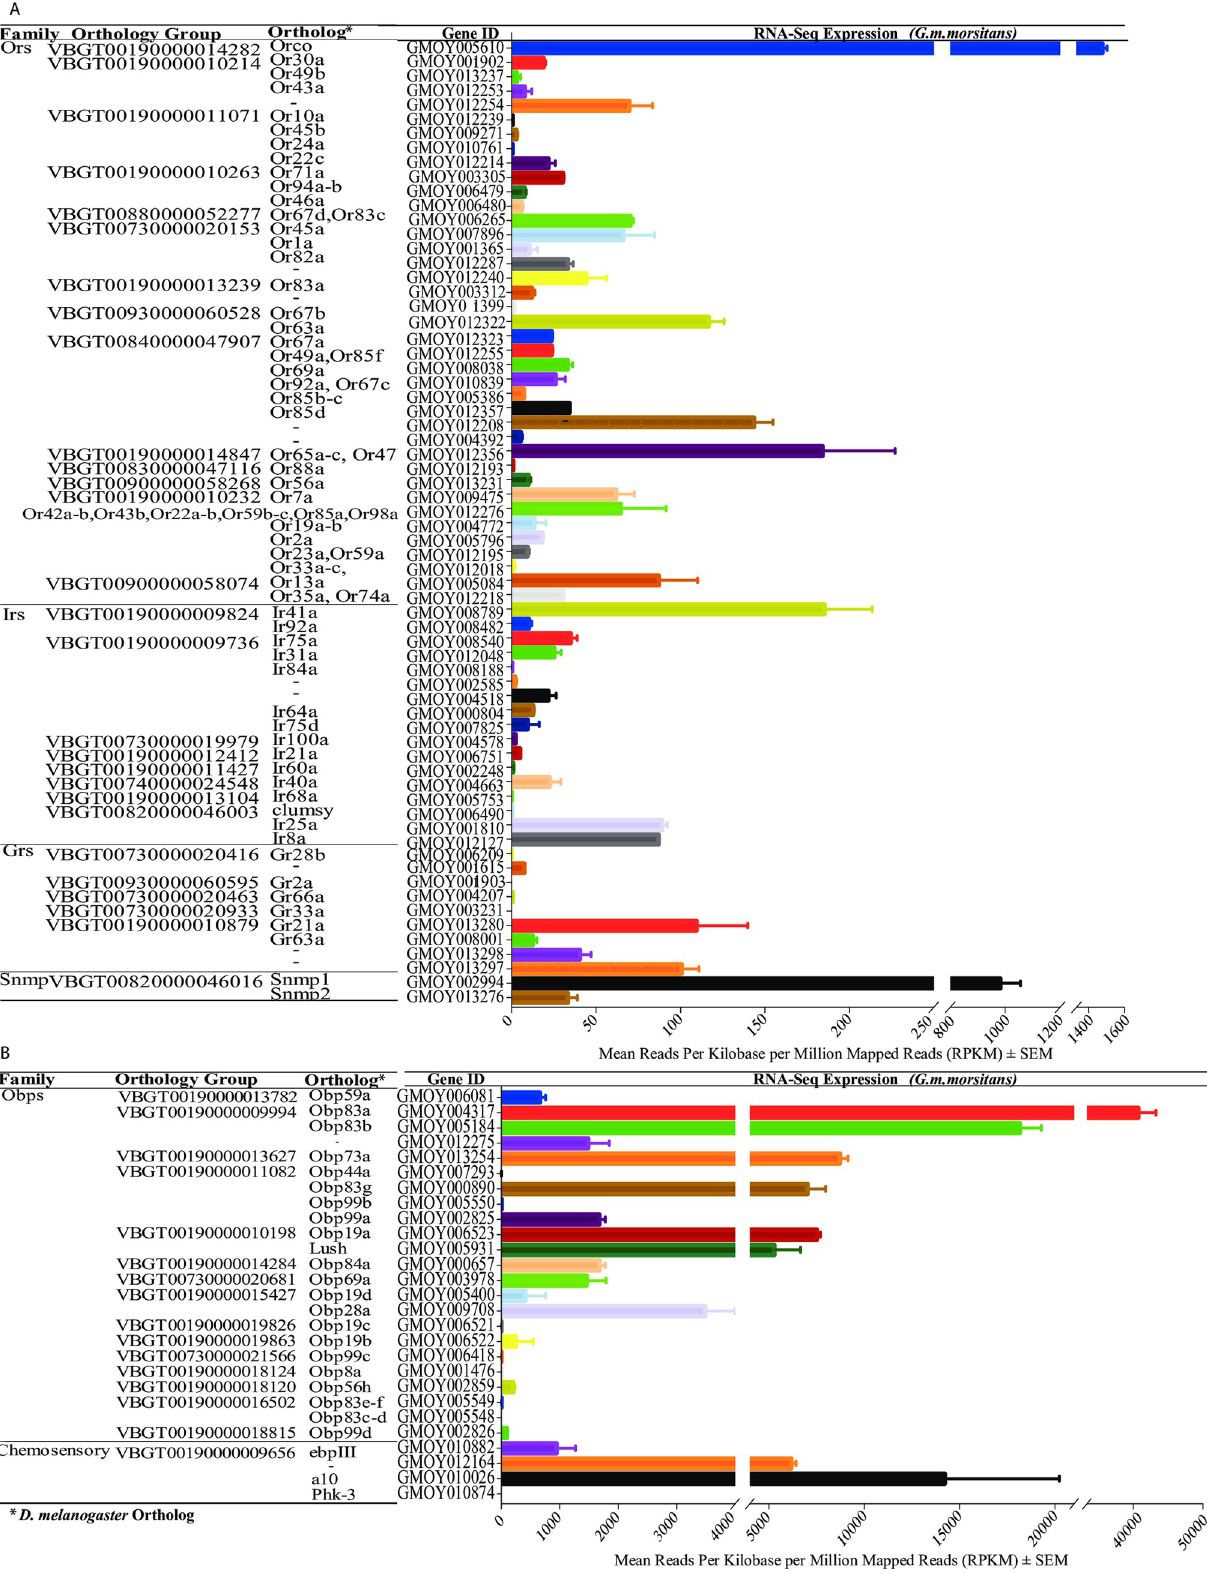
Fig 2. Expression profiles of D . melanogaster chemosensory gene orthologs in male G . m . morsitans antennae 72 hrs post feeding.